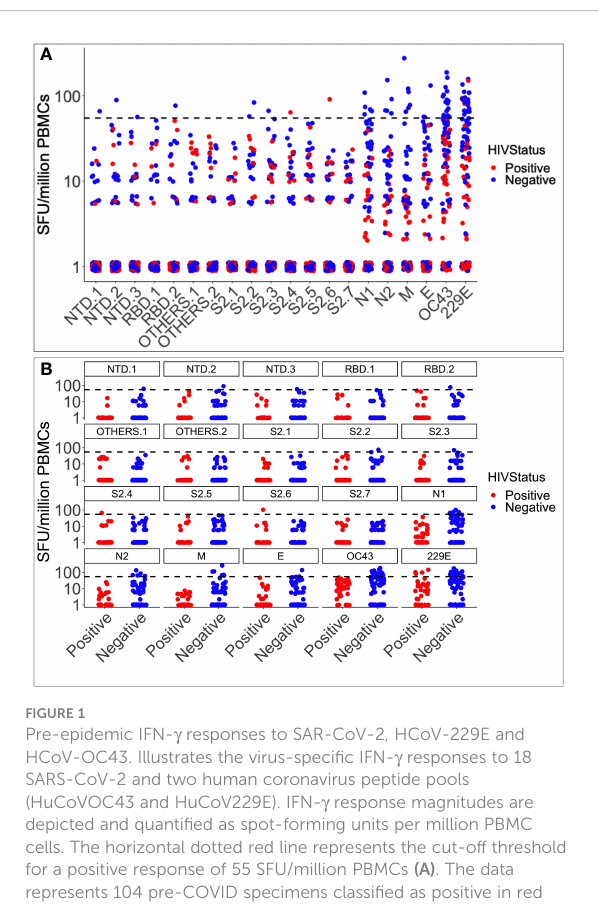
FIGURE 1 Pre-epidemic IFN- g responses to SAR-CoV-2, HCoV-229E and HCoV-OC43. Illustrates the virus-speci fi c IFN- g responses to 18 SARS-CoV-2 and two human coronavirus peptide pools (HuCoVOC43 and HuCoV229E). IFN- g response magnitudes are depicted and quanti fi ed as spot-forming units per million PBMC cells. The horizontal dotted red line represents the cut-off threshold for a positive response of 55 SFU/million PBMCs (A) . The data represents 104 pre-COVID specimens classi fi ed as positive in red and negative in blue based on HIV serostatus (B)